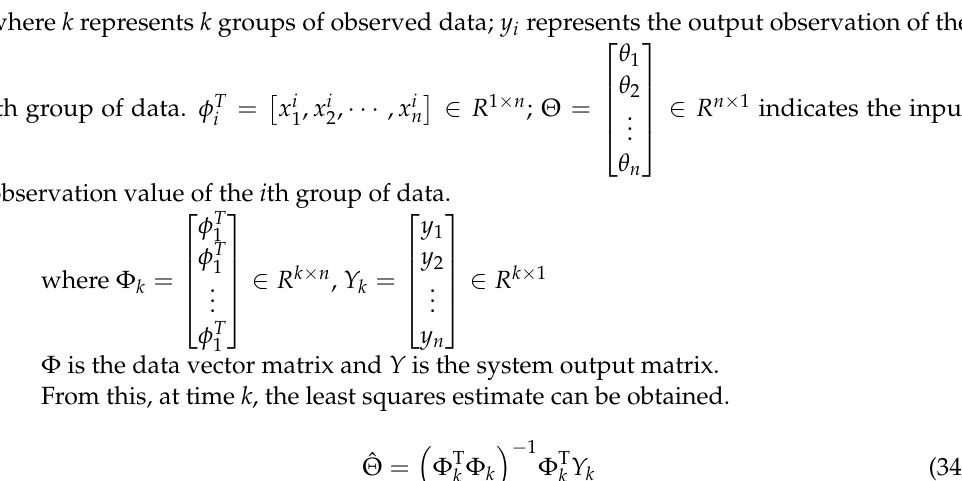
Figure 5. Convergences of the objective function for G best .